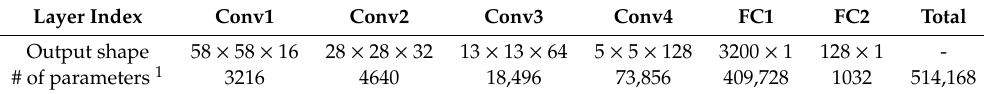
Figure 9. Proposed architecture of the key frame-based CNN. Table 2. Details of the structure of the key frame-based CNN.